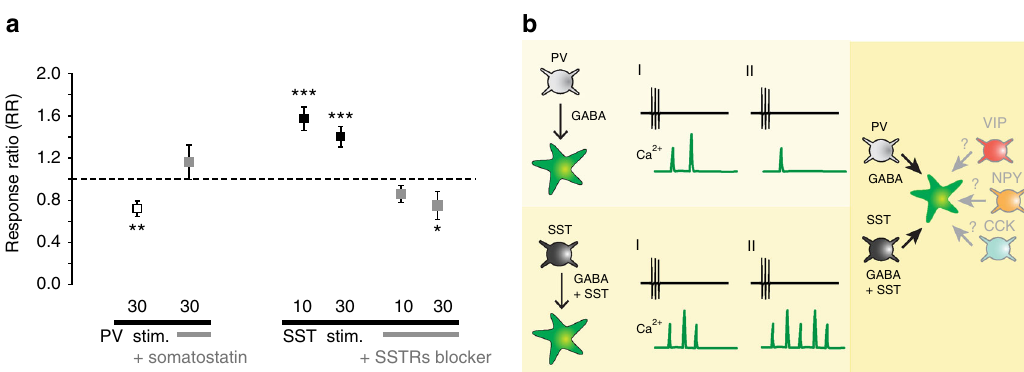
Fig. 8 Speci fi city of neuropeptide-releasing interneuron signaling to astrocytes. a Astrocyte response ratio (RR, see Methods) of the second versus the fi rst 10 or 30 light pulse stimulation of PV or SST interneurons in the absence or presence of the neuropeptide SST or of a somatostatin receptors (SSTRs) blocker. * p ≤ 0.05, ** p ≤ 0.01, *** p ≤ 0.001. Data are represented as mean ± SEM. b Schematic of the signaling speci fi city to astrocytes of SST and PV interneurons (left) and of the potential recruitment of the astrocytic network by different neuropeptide-releasing interneurons